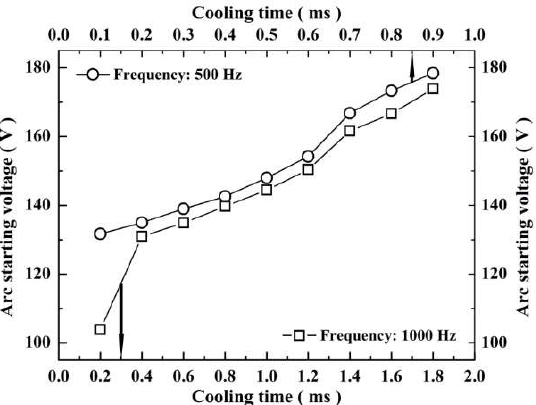
Figure 10. The arc start voltage at the frequency is 500 Hz and 1000 Hz, the duty cycle is from 10% to 90%.